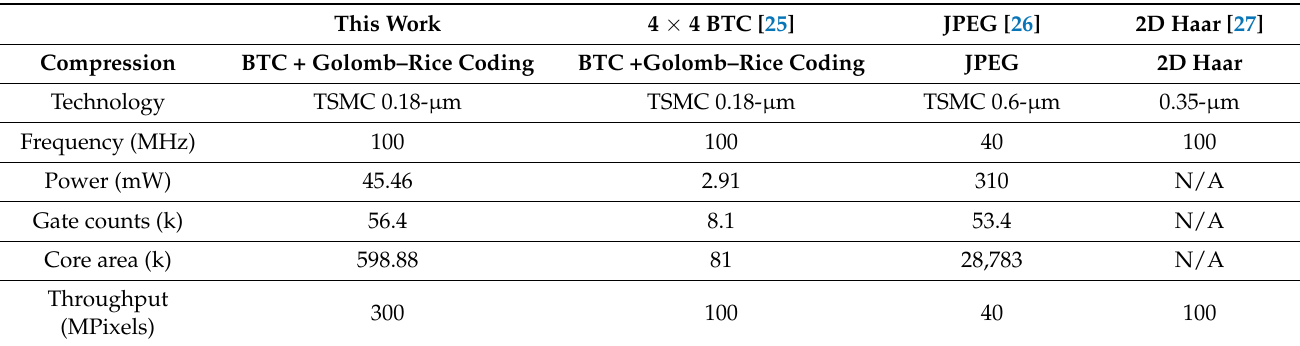
Table 7. Chip specification of this work and other chip